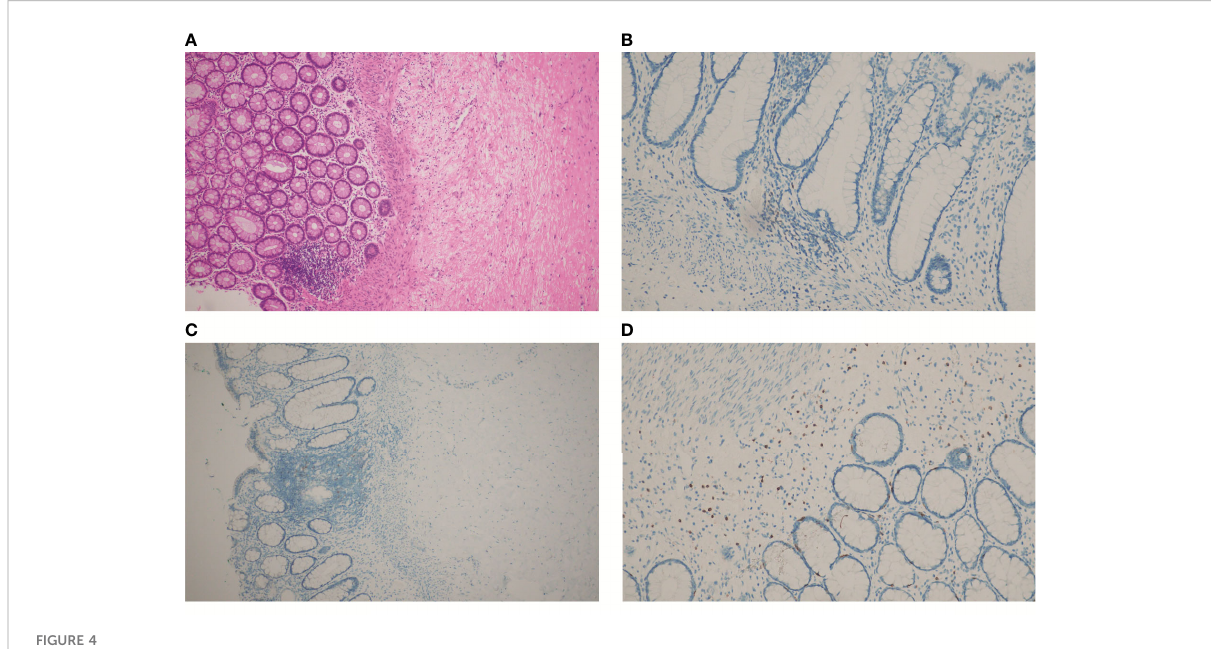
FIGURE 4 HE and IHC staining on tumor tissues of the patient after chemotherapy, immunotherapy, and surgery: (A) HE staining; (B) IHC staining of CD3; (C) IHC staining of PD-1; (D) IHC staining of CD8. (A, C) , at 100× magni fi cation; (B, D) , at 200× magni fi